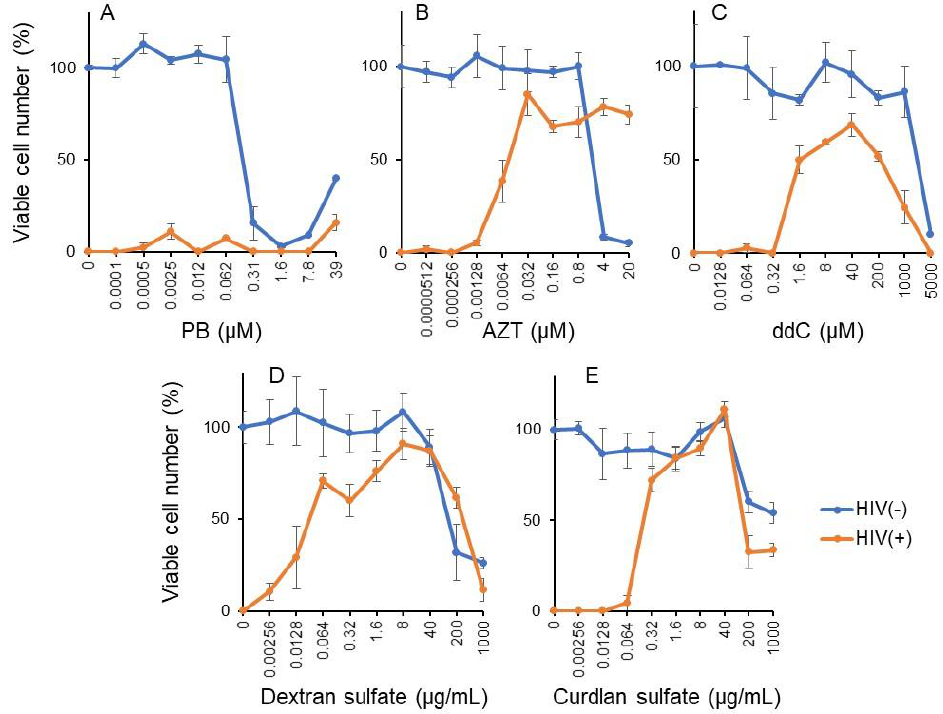
Figure 5. PB failed to induce anti-HIV activity. Mock and HIV-infected MT-4 were treated with the indicated concentrations of pyoktanin ( A ), AZT ( B ), ddC ( C ), dextran sulfate ( D ), and curdlan sulfate ( E ) for 5 days to determine the viability by MTT method. Each value represents mean ± S.D. of triplicate assay. Table 3. Quantification of anti-HIV activity of